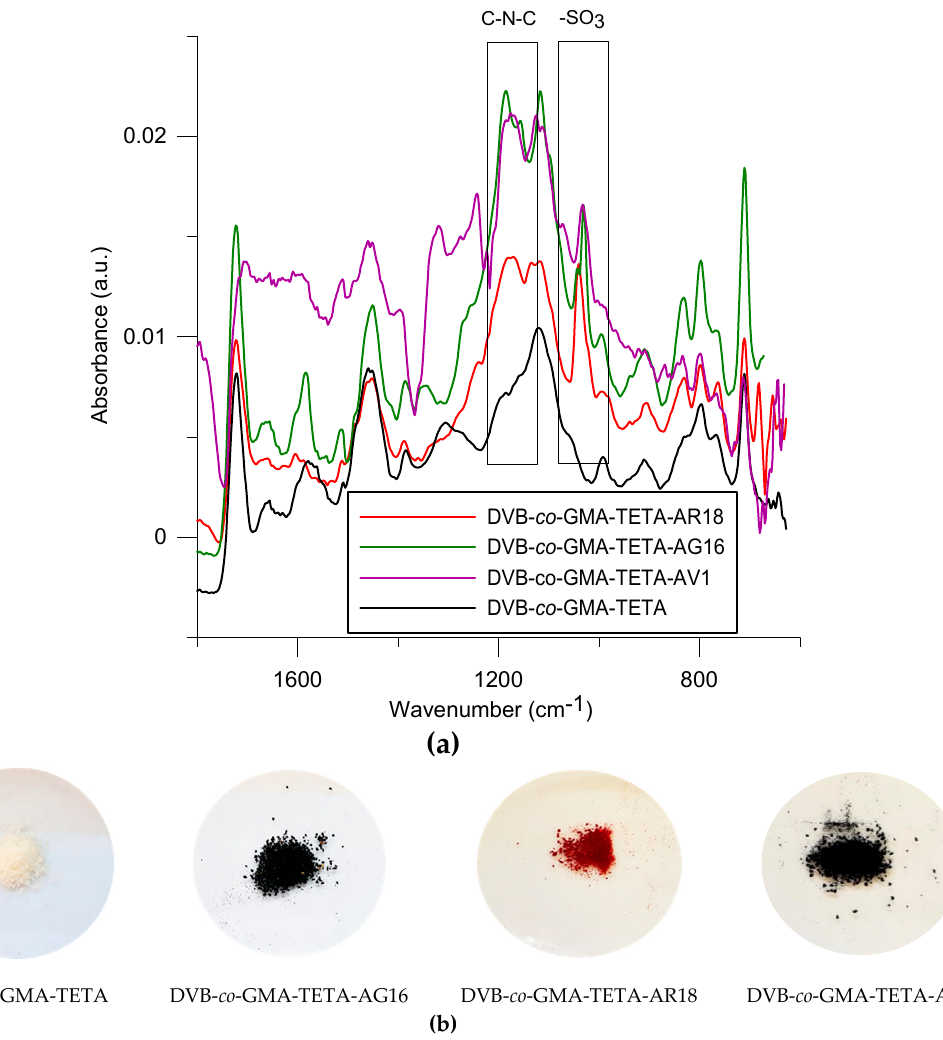
Figure 4. ATR-FT-IR spectra of DVB- co -GMA-TETA before and after dye sorption ( a ) as well as ( b ) photos of the microspheres before and after the sorption process.